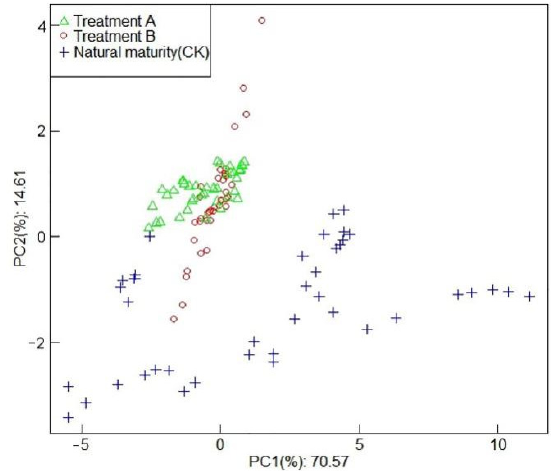
Figure 7. Classification result based on principal component analysis (PCA).